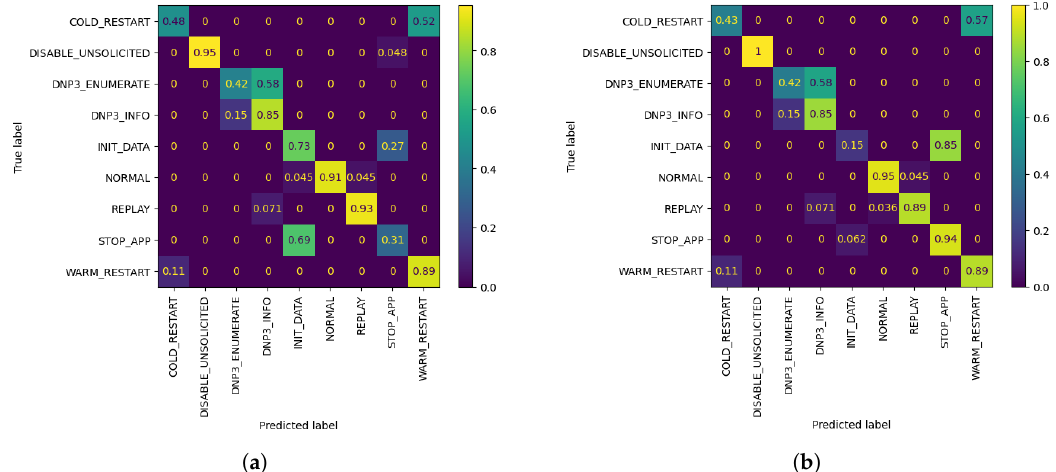
Figure 5. W1 Confusion Matrices. ( a ) W1’s evaluation of global FL model after r = 3 using its evaluation dataset; ( b ) W1’s evaluation of customized model by AL, after Q = 10 queries, using its evaluation